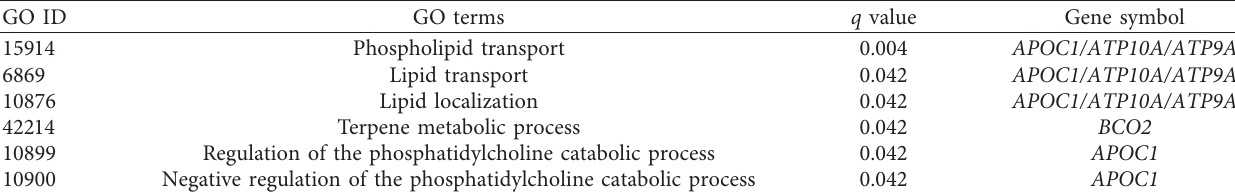
Table 3: GO enrichment analysis of real hub genes using the Cytoscape